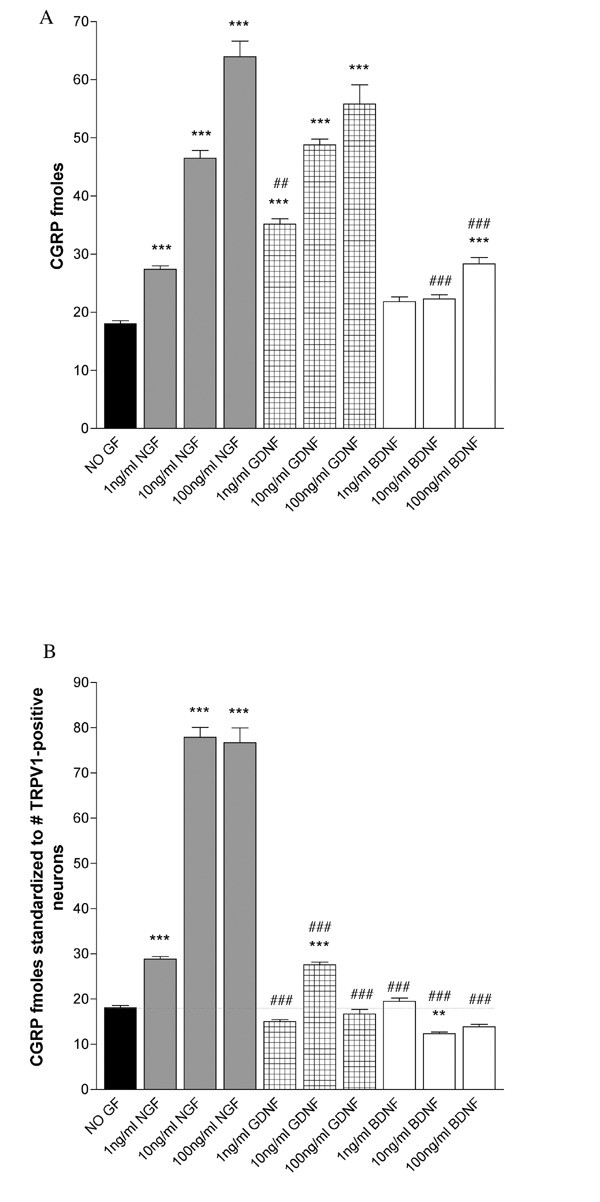
Growth factor treatment increases CAP (100 nM)-evoked CGRP release in TG cultures. Panel A illustrates the total amount of CGRP released by 10 min treatment with capsaicin for each growth factor. Panel B illustrates the same data standardized to the number of TRPV1-positive neurons under each growth factor condition (** p < 0.01, *** p < 0.01 for comparisons to no growth factor treated controls; ## p < 0.01, ### p < 0.001 for comparisons to NGF at the equivalent growth factor concentration by two-way ANOVA with Bonferroni post-test; n = 6).